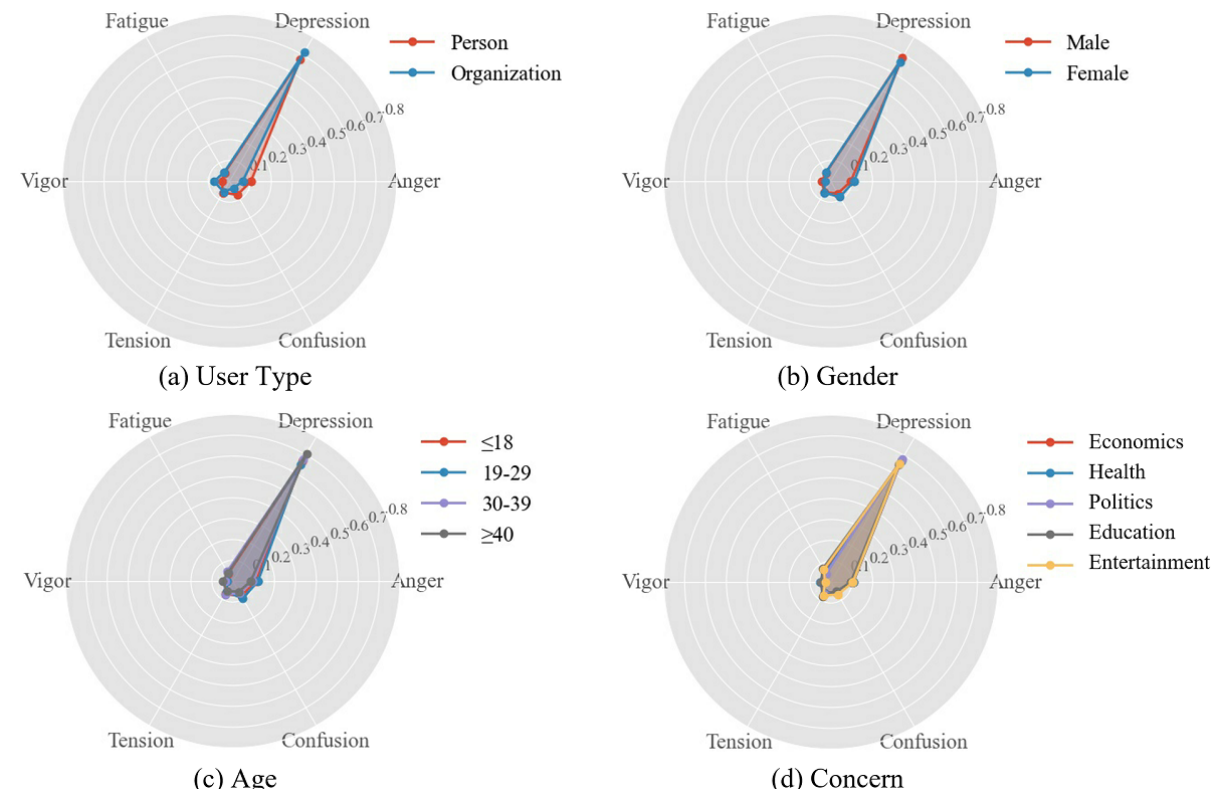
Figure 10. Profile of Mood States (POMS) emotion analysis on four population characteristics. Scores range from 0 to 1 for each